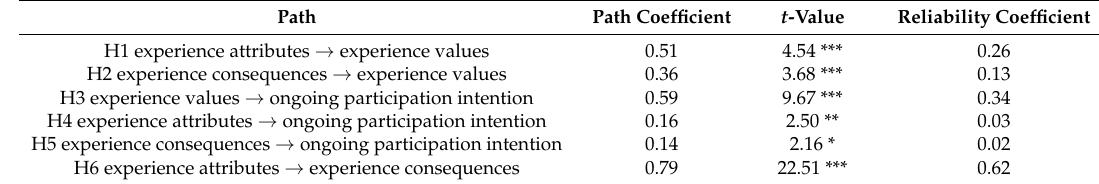
Table 5. Estimates of the path coefficients in the research model.